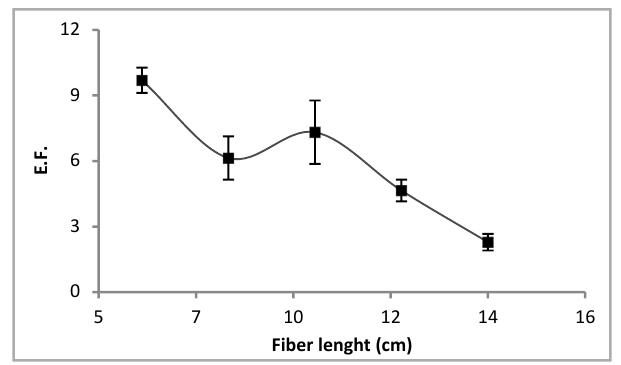
Figure 3. Effect of the fibre length on the enrichment factor. Sample: 0.1 µg L −1 Cd 2+ in NaNO 3 1 M and HEPES 0.1 M. Liquid membrane: Cyanex ® 272 1 M in dihexyl ether. Acceptor solution: HNO 3 1 M. Extraction time: 180 min. Stirring rate: 200 rpm.